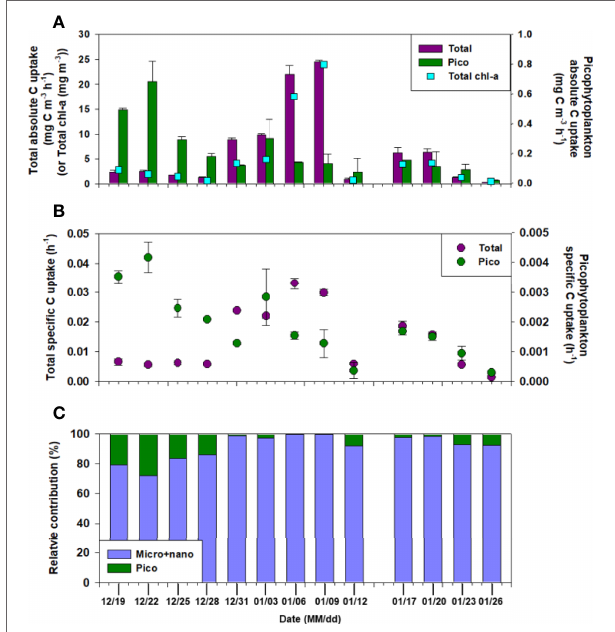
FIGURE 4 | Hourly (A) carbon and (B) specific uptake rates for total and picophytoplankton, and (C) the relative contribution of size-fractionated phytoplankton each sampling date.